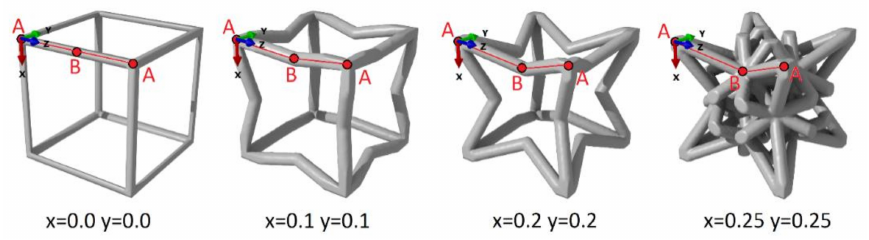
Figure 1. Cubic lattices designed by setting the (x, y) coordinates of the B